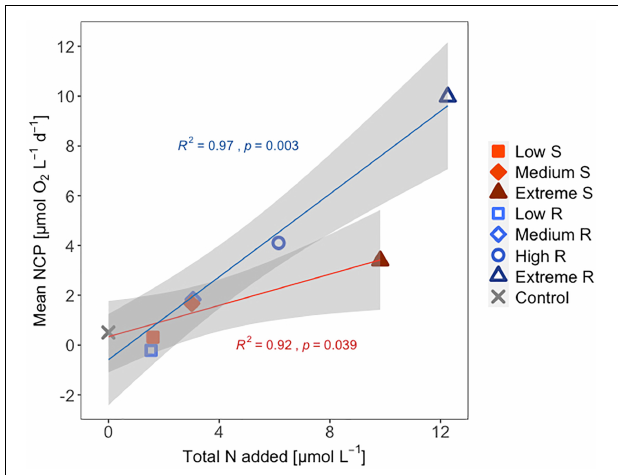
FIGURE 3 | Mean NCP [ µ mol O 2 L − 1 d − 1 ] of each treatment vs. amount of inorganic N added [ µ mol L − 1 ]. S, singular; R, recurring treatment. Shaded area shows the 95% confidence interval. R 2 - and p -values shown for the linear regression line of each upwelling mode + control.